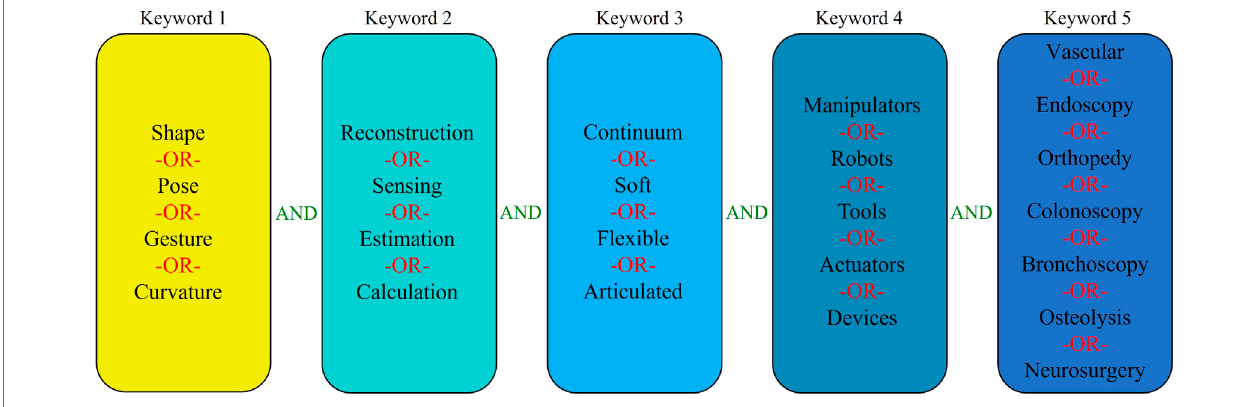
FIGURE 1 | Methodology of literature